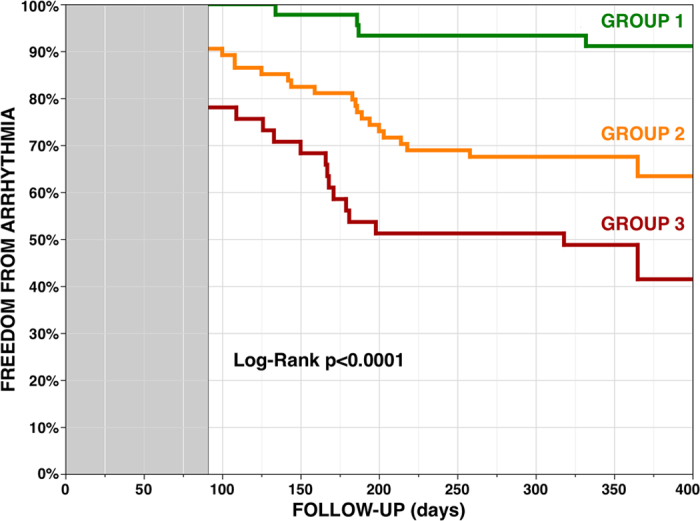
Arrhythmia-free survival without anti-arrhythmic drug after a single ablation procedure in patients with galectin-3 level <15 ng/mL and a left atrial diameter <40 millimeters (Group 1, 28%), either galectin-3 level ≥15 or a left atrial diameter ≥40 (Group 2, 46%), or both galectin-3 level ≥15 and a left atrial diameter ≥40 (Group 3, 26%) (3-month blanking period).